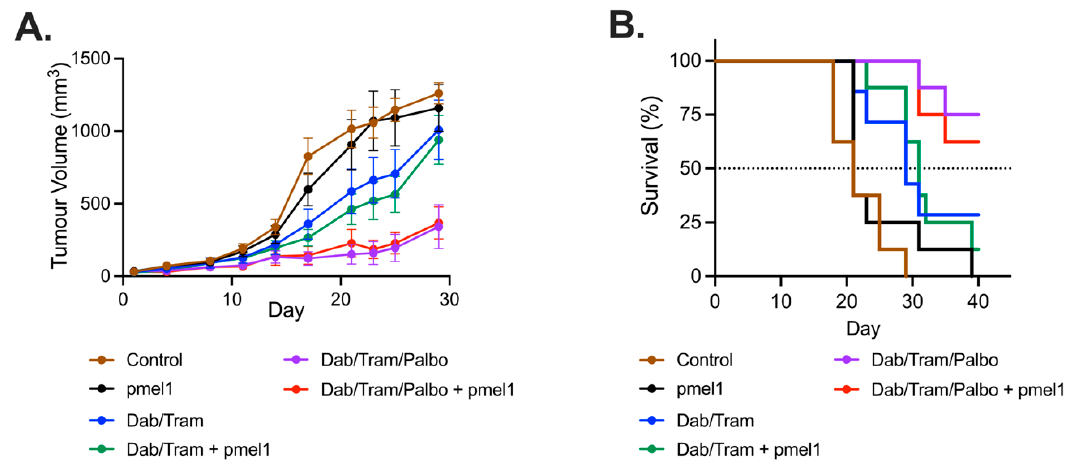
Figure 3. SM1WT1 tumor response to targeted therapy and ACT. ( A ) SM1WT1 tumor volume growth curves of dabrafenib-trametinib (DT) ± palbociclib (P) and pmel-1 adoptive cell transfer (ACT) with 8 mice per group (mean ± SEM). ( B ) Kaplan–Meier overall survival (OS) curves of data shown in ( A ). Median OS for control, pmel-1, DT, DT + pmel-1, DTP, and DTP + pmel-1 was 21, 21, 29, 31, not attained, and not attained, respectively. OS hazard ratio (HR) for control versus pmel-1 was 1.57, p = 0.32. OS HR for DT versus DT + pmel-1 was 0.995, p > 0.99. OS HR for DTP versus DTP + pmel-1 was 0.627, p = 0.58. OS HR for DT versus DTP was 4.695, p = 0.03. Hazard ratios determined with log-rank (Mantel-Cox).